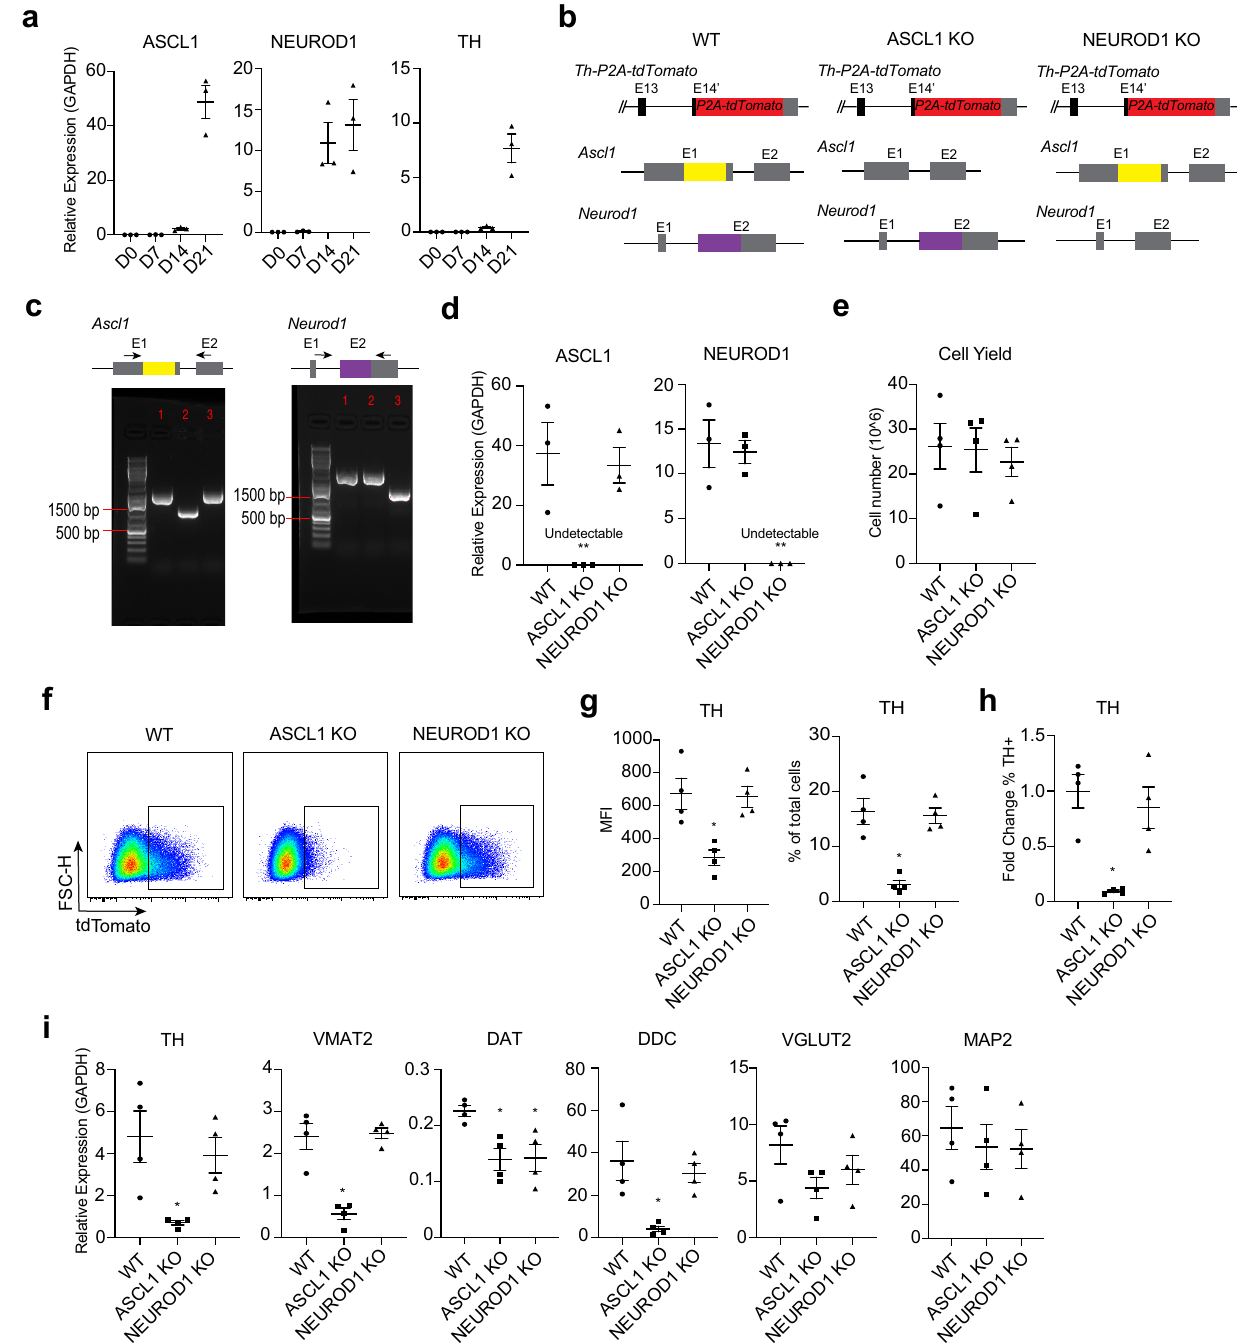
Figure 4. Distinct loss of function effects of ASCL1 and NEUROD1 on neurotransmitter selection in human iPSC- derived neurons. ( a ) RT-qPCR of culture temporal gene expression ( n = 3 independent differentiations, relative gene expression normalized GAPDH). ( b ) Gene structure of iPSC KO lines; exons-boxes and introns-lines. ASCL1 coding sequence, yellow. NEUROD1 coding sequence, purple. ( c ) Gel electrophoresis of genomic DNA PCR for ASCL1 ( left ) and NEUROD1 ( right ); lane 1-WT, lane 2-ASCL1 KO, lane 3-NEUROD1 KO lines. ( d ) RT-qPCR of culture gene expression for ASCL1 and NEUROD1 for iPSC KO lines ( n = 3 independent differentiations, relative gene expression normalized GAPDH, **Undetectable). ( e ) Trypan blue cell count of total cell numbers from dissociated cultures ( n = 4 independent differentiations). ( f ) FACS plot of live TH expressing cells for WT, ASCL1 KO, and NEUROD1 KO lines. ( g ) Mean fluorescent intensity ( left ) and percentage TH + expressing cell ( right ) quantification of FACS analysis from ( f ) ( n = 4 independent differentiations). ( h ) Intracellular TH staining quantified by flow cytometry for WT, ASCL1 KO, and NEUROD1 KO lines ( n = 4 independent differentiations). ( i ) RT-qPCR culture gene expression of dopaminergic, glutamatergic, and pan-neural genes for WT, ASCL1 KO, and NEUROD1 KO lines ( n = 4 independent differentiations, relative gene expression normalized GAPDH). Error bars for ( a , d , e , g , h , i ), mean ± SEM. Kruskal Wallis test with Dunn’s post-hoc test for ( g , h , i ), * p < 0.05 significance compared to